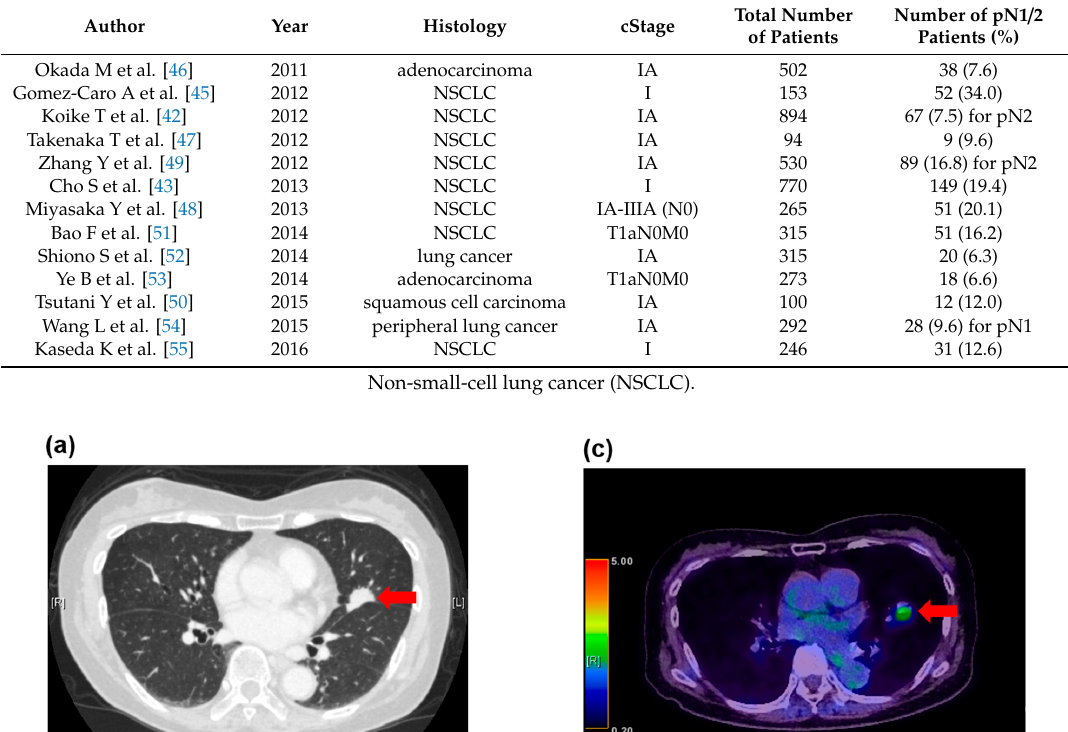
Table 1. Representative studies on the incidence of pathological nodal metastasis in clinical N0 lung cancer.